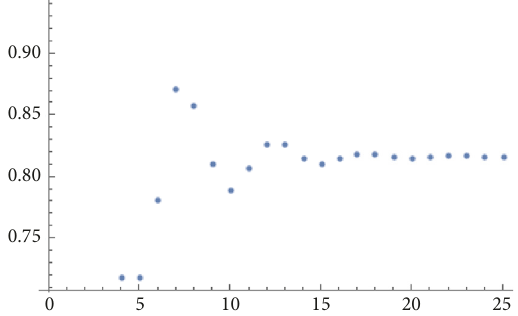
Figure 7: Convergence of 𝐼 𝑁 = ∑ 𝑁 𝑝=0 𝑐 𝑝 as a function of 𝑁 up to 𝑁 = 25 .